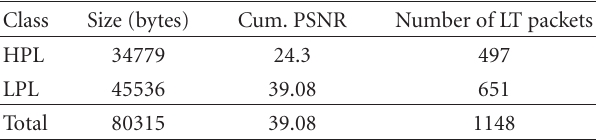
Table 4: Priority class and LT packetization for first GOP of “Paris” sequence.